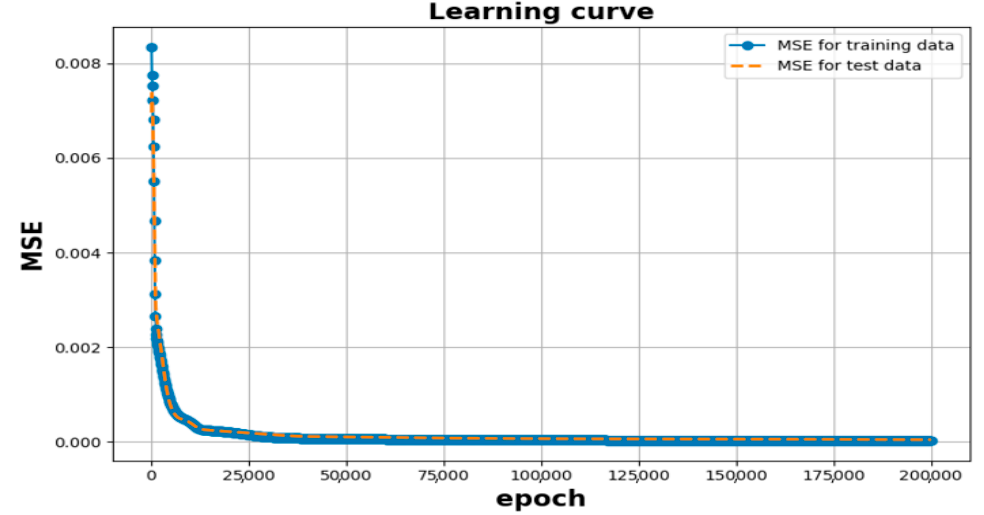
Figure 2. Learning curves for the training and the test data.